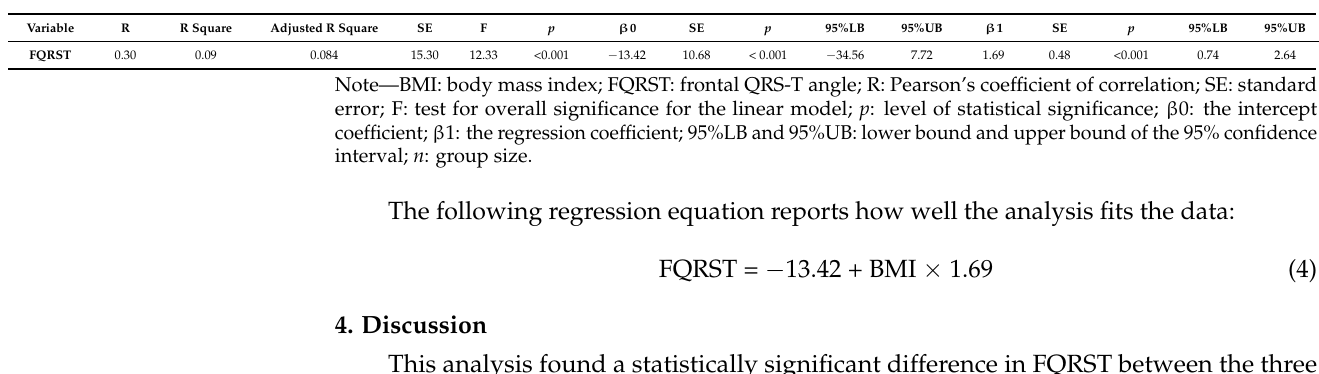
Table 7. Model summary, ANOVA report, and coefficients for simple linear regression analysis—BMI versus FQRST ( n = 124).